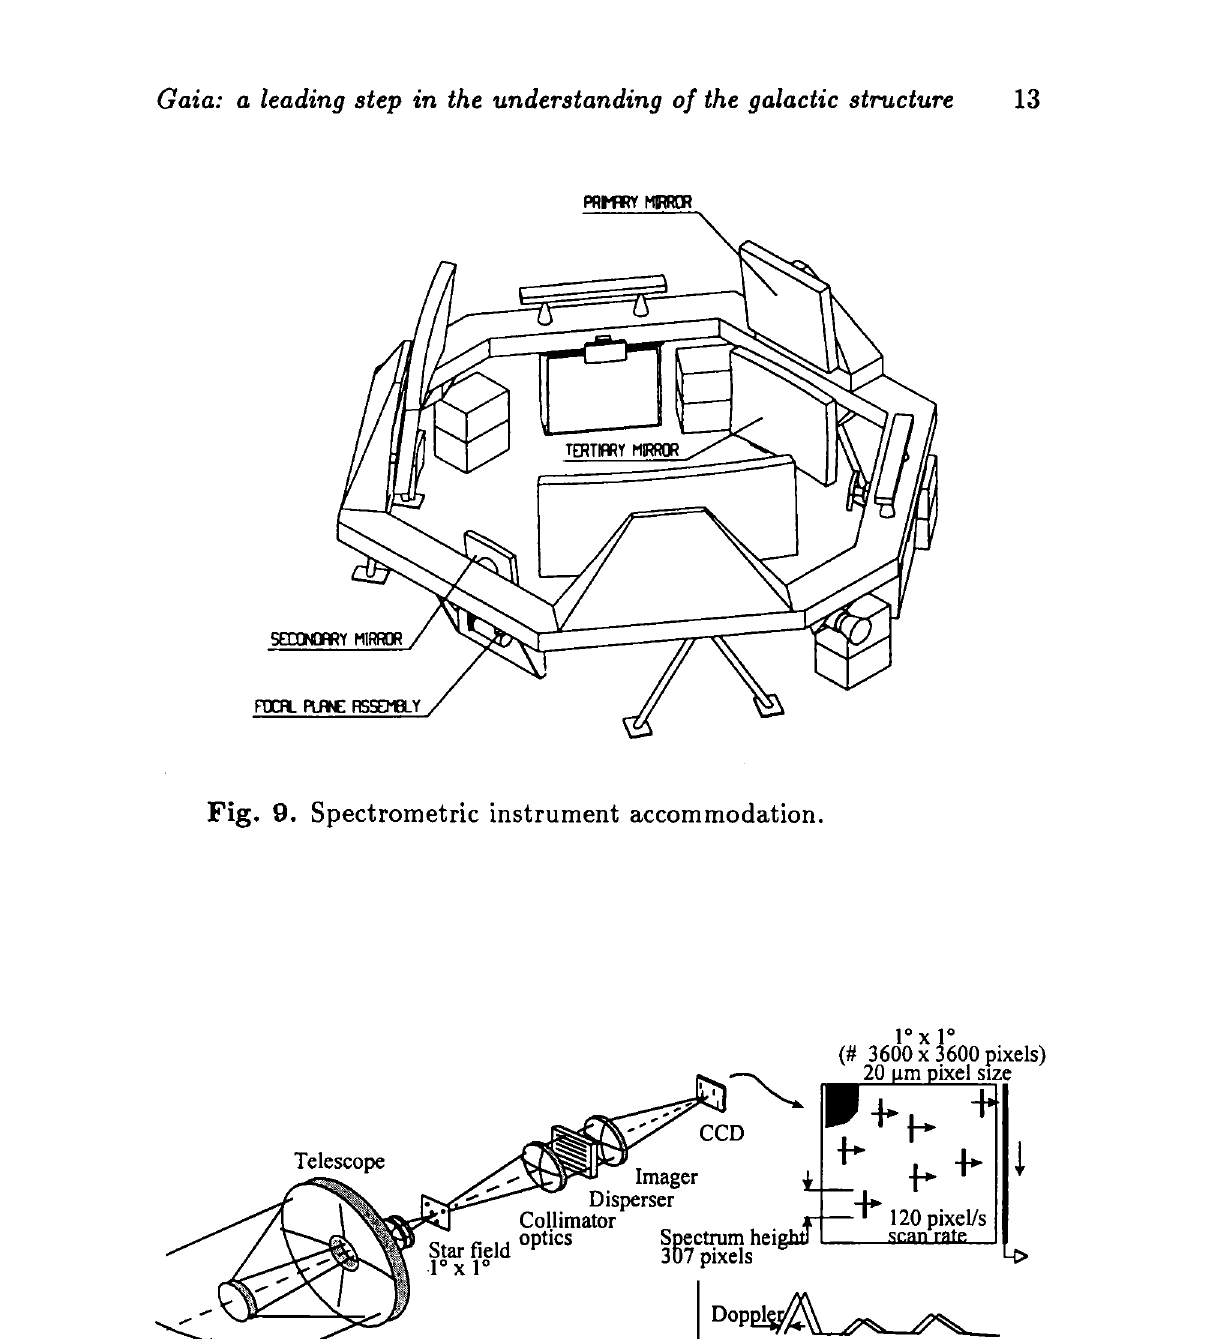
Fig. 10. Radial velocity measurement